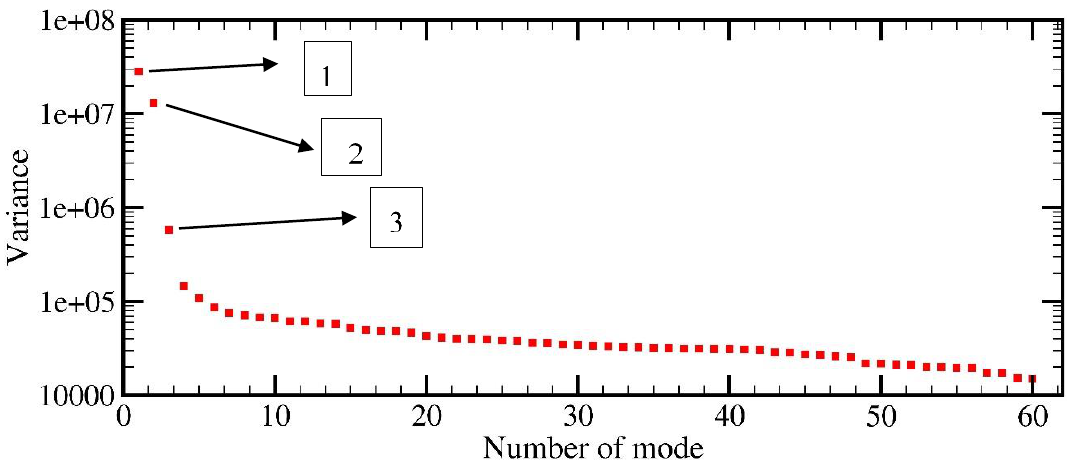
Figure 7. Singular values spectrum of data with a window size of 60 images showing three modes (note: the vertical axis shows the log-transformed variance of three modes).